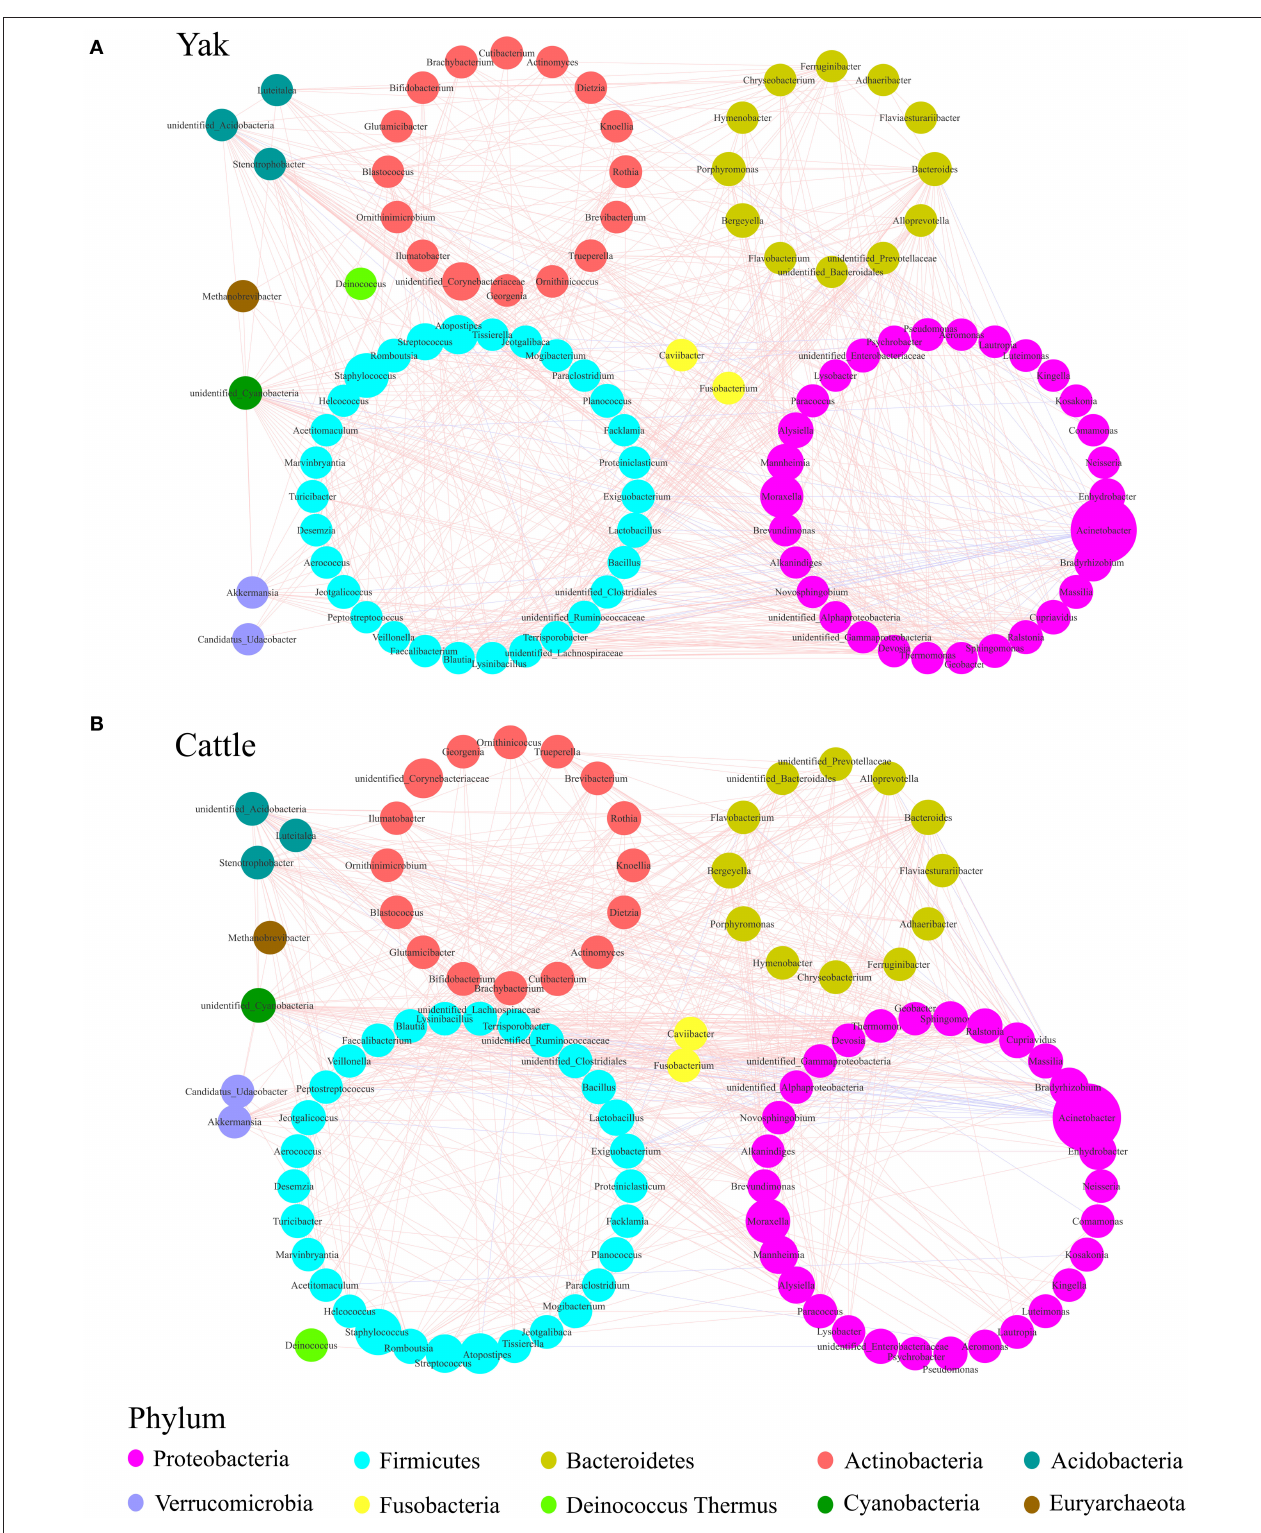
FIGURE 4 | Genera co-occurrence network of core microbiota of udder skin between yak and cattle based on Spearman’s correlation algorithms. Spearman’s method was used to analyze the correlation between the udder skin core microbiota of yak (A) and cattle (B) , respectively, and the Cytoscape_3.7.1 software was used to draw the co-occurrence network of the core microbiota with P -value < 0.05 and the absolute value of correlation > 0.6. Each node presents a bacterial genus. The node size indicates the relative abundance of each genus per group, and the density of the dashed line represents Spearman’s correlation coefficient. Red links stand for positive interactions between nodes, and blue links stand for negative